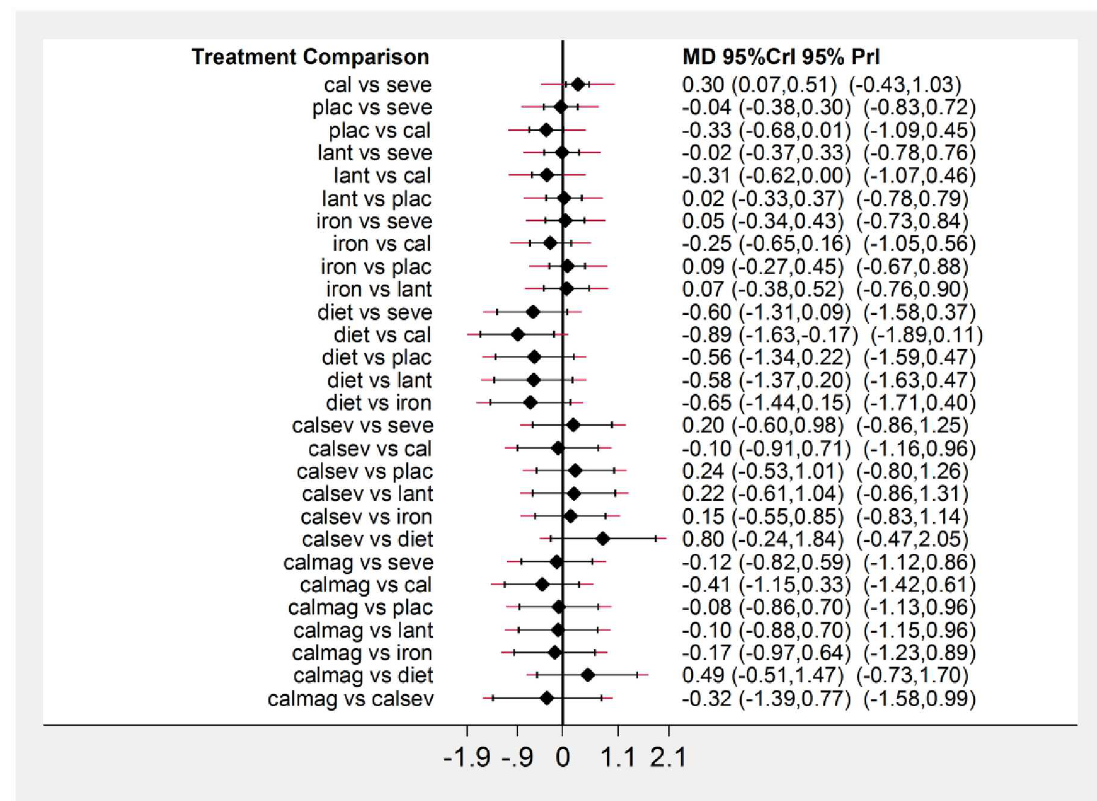
Fig 7. Network meta-analysis results for serum calcium. Forest plot of effectivenessoutcome for mean calciumreductionat the end of the study period; MD: Mean difference; Crl: Credibleinterval; PrI: predictive intervals.